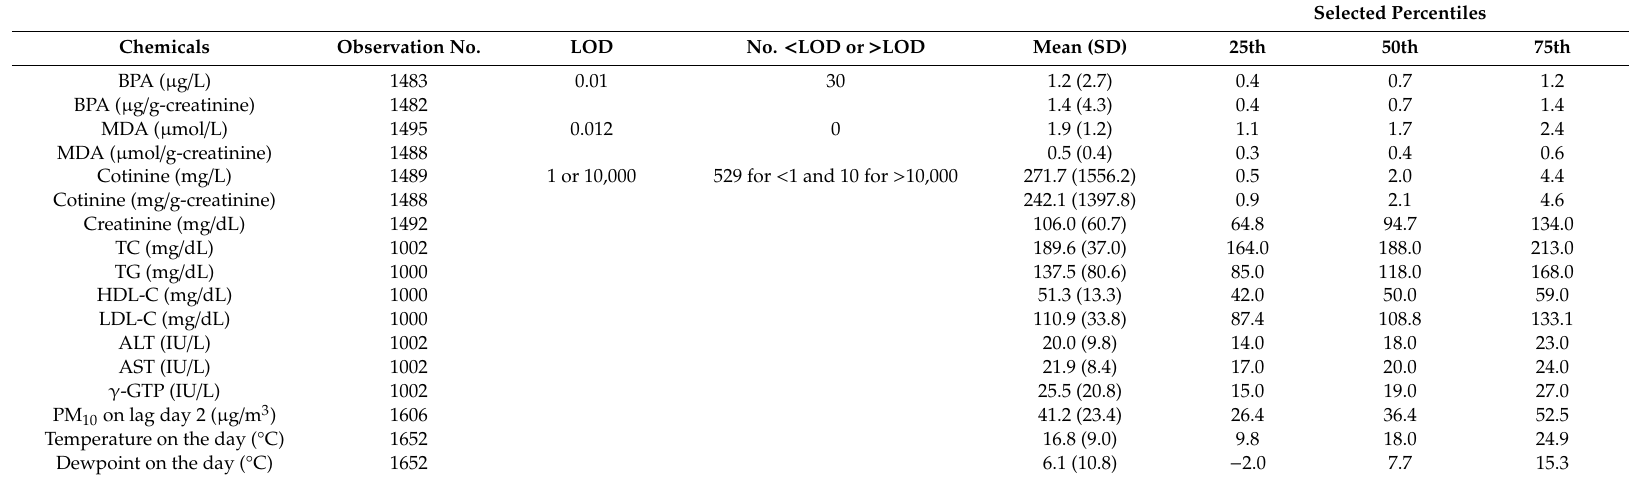
The limit of detection (LOD) levels were 0.01 µ g / L for BPA and 0.012 µ mol / L for malondialdehyde (MDA). BPA concentrations under LOD were assigned as the LOD concentration divided by two, whereas all MDA levels were over the LOD level. Creatinine-corrected urinary BPA and MDA concentrations were used to control the di ff erent urinary excretion rates. Because the